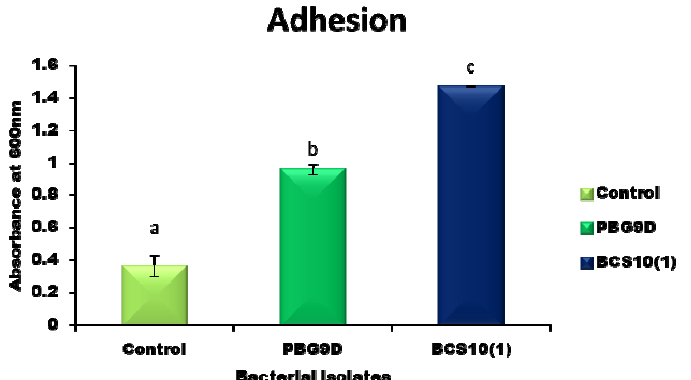
Figure 4. In vitro adhesion capacity of bacterial isolates. Values represent mean ± SD (n = 3). Different letters on bars indicate significant difference ( p ≤ 0.05) between groups (PBG9D and BCS10 (1)).